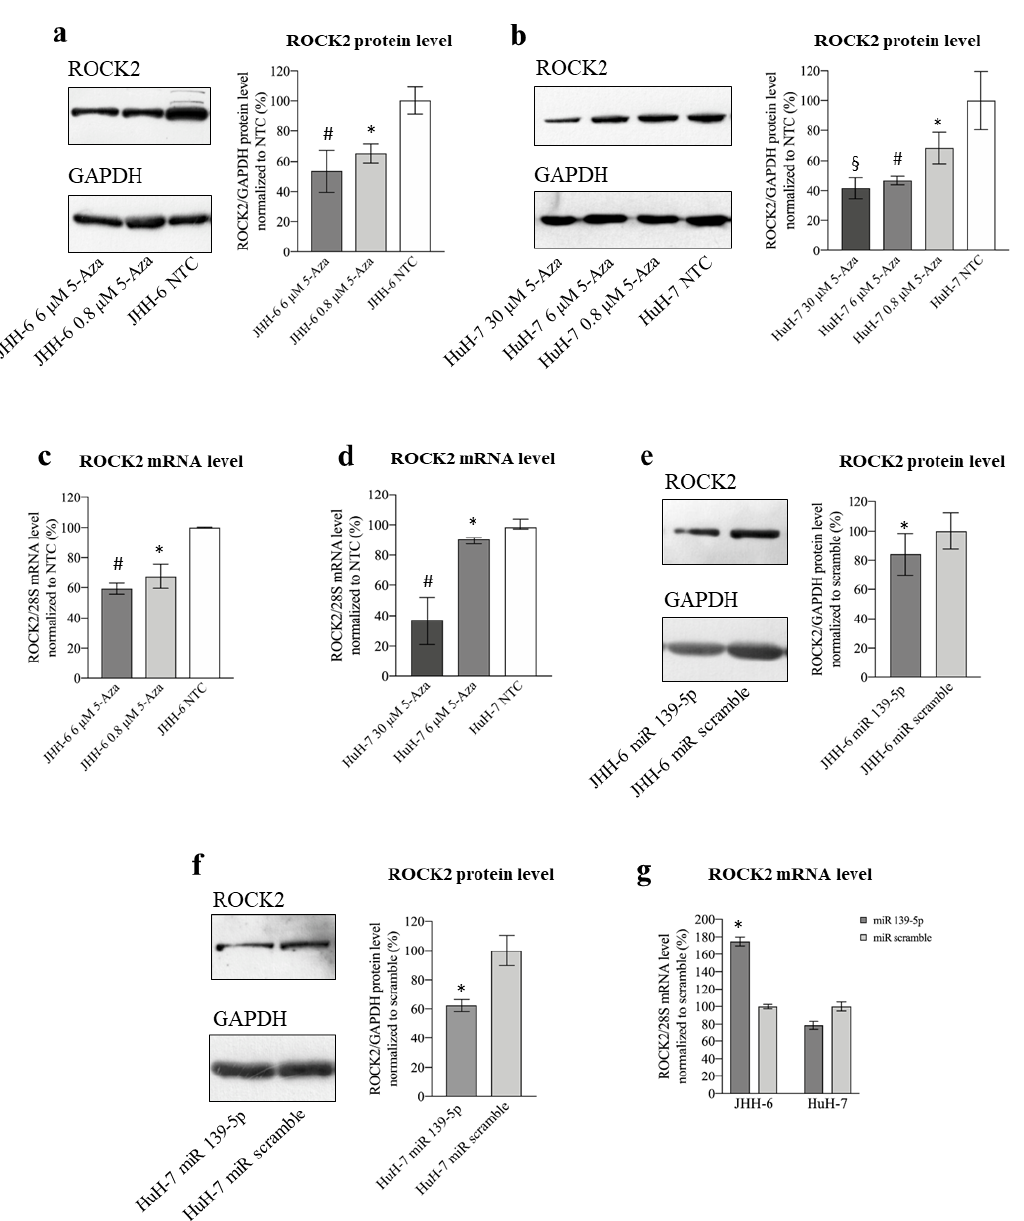
Figure 4. Effects of 5-Aza and miR-139-5p on ROCK2 expression. ( a ) Effects of 5-Aza on ROCK2 protein level in JHH-6. Left, representative Western blot (GAPDH was introduced for normalization); right, data normalized to GAPDH levels and to the average of non-treated cells (NTC) are reported in % as mean ± SEM, n = 6; NTC vs. 0.8 μ M, * p = 0.0398; NTC vs. 6 μ M, # p = 0.0177. ( b ) Effects of 5-Aza on ROCK2 protein level in HuH-7. Left, representative Western blot; right, data normalized to GAPDH levels and to the average of NTC are reported in % as mean ± SEM, n = 4; NTC vs. 0.8 μ M,